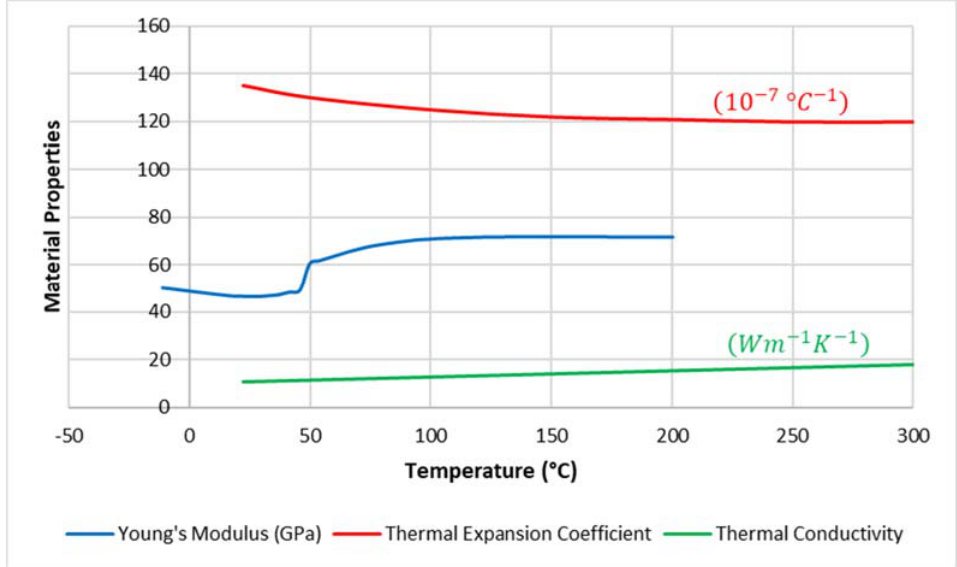
Figure 2. Chart displaying the following material properties as functions of temperature for NiTi; Young’s Modulus [14], coefficient of linear thermal expansion [15], and thermal conductivity